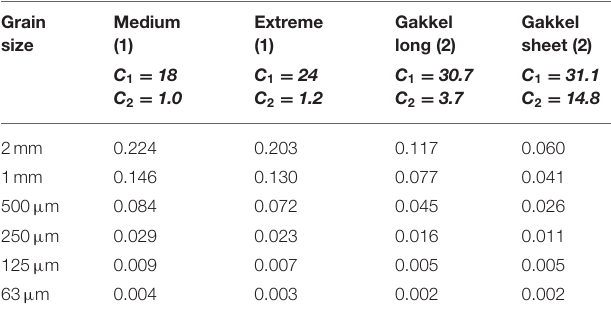
TABLE 2 | Particle settling rates in m s − 1 calculated using Equation (4) from Ferguson and Church (2004) across a range of grain sizes for a range of particle morphologies with shape factors (C1 and C2) defined by Ferguson and Church (2004) (1) and Barreyre et al. (2011)